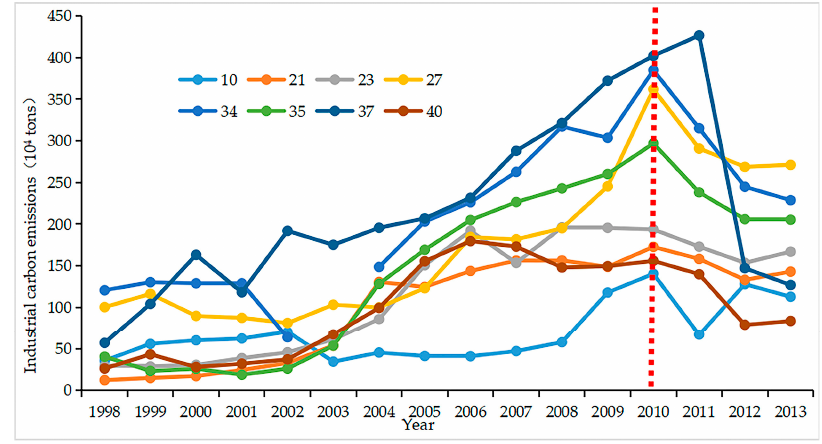
Figure 7. Changes in the Carbon Emissions of the Fluctuant Growth Type Industries in Guangdong from 1998 to 2013.